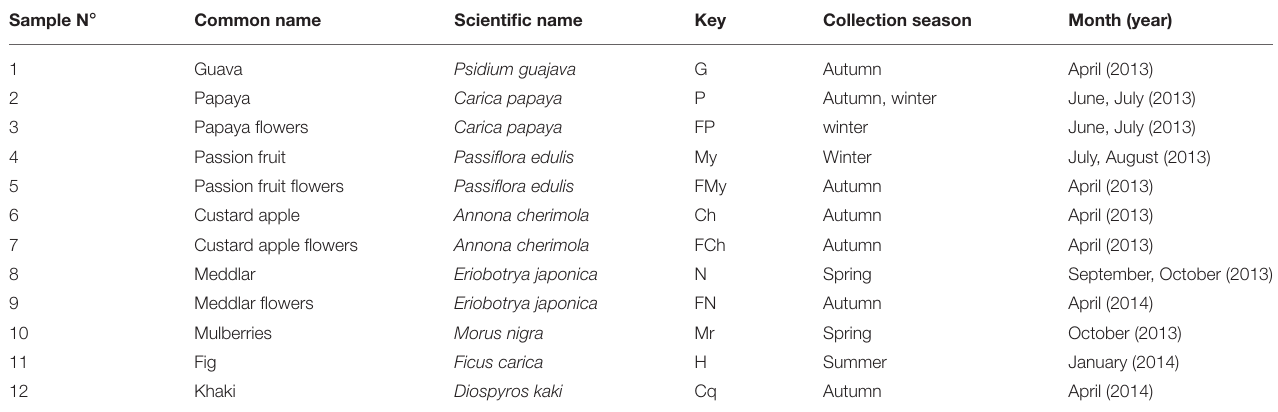
TABLE 1 | Tropical fruits and flowers from Northern Argentina studied in this work. Sample N